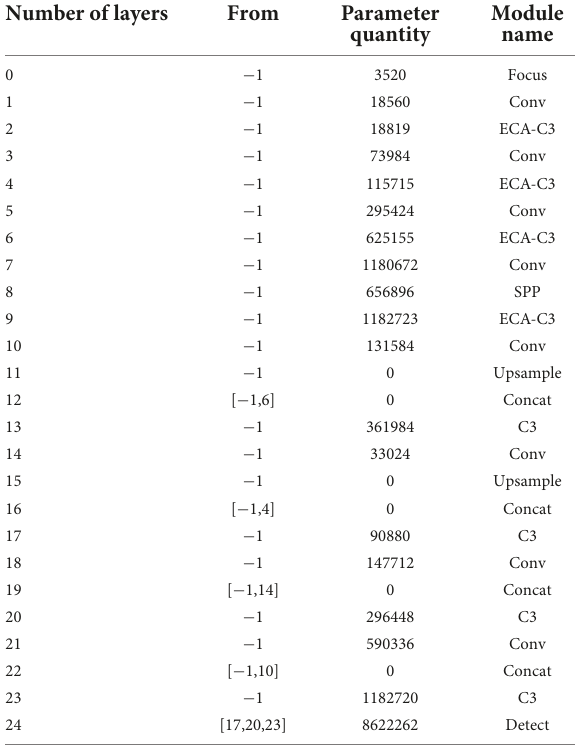
TABLE 1 Algorithm structure of improved